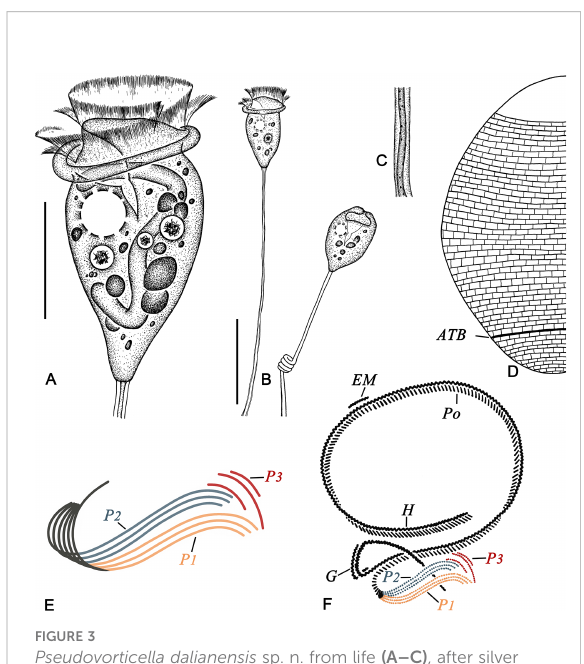
FIGURE 3 Pseudovorticella dalianensis sp. n. from life (A – C) , after silver nitrate staining (D) and after protargol staining (E, F) . (A) Typical shape of the zooid. (B) Complete individuals with stalk and zooid. (C) Details of the stalk and spasmoneme. (D) Silverline system. (E) Arrangement of the three infundibular polykineties. (F) Oral ciliature. ATB, aboral trochal band; EM, epistomial membrane; G, germinal kinety; H, haplokinety; Po, polykinety; P1 – 3, infundibular polykinety 1 – 3. Scale bars: 30 m m (A) and 60 m m (B)